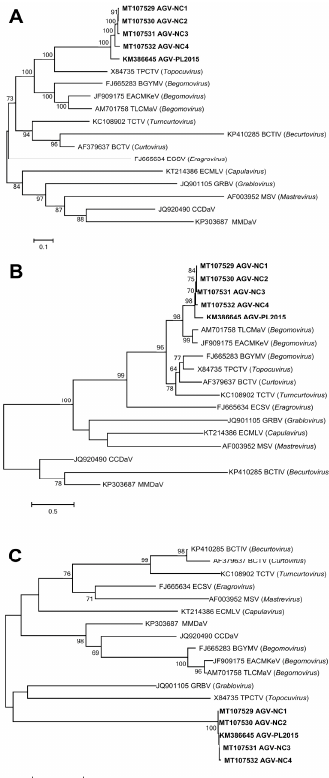
Figure 1. Phylogenetic relationships of AGV and other members in the family Geminiviridae. The trees were reconstructed based on complete genome sequences ( A ), amino acid sequences of Rep ( B ) and amino acid sequences of CP ( C ), respectively. AGV isolates are marked in bold. Numbers on the branches indicate bootstrap percentage after 1000 replications in constructing the tree. Scale bar refers to a phylogenetic distance of 0.5 or 0.1 nucleotide substitutions per